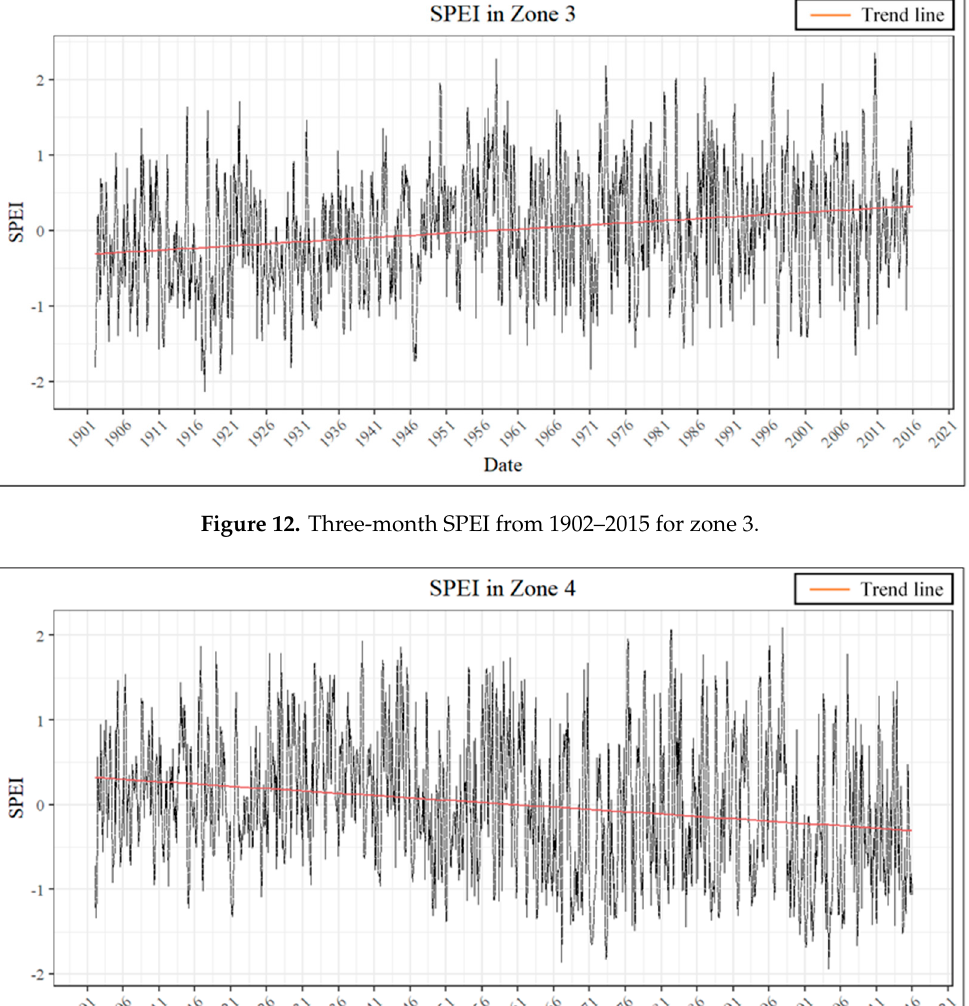
Figure 15. Drought durations for each zone.